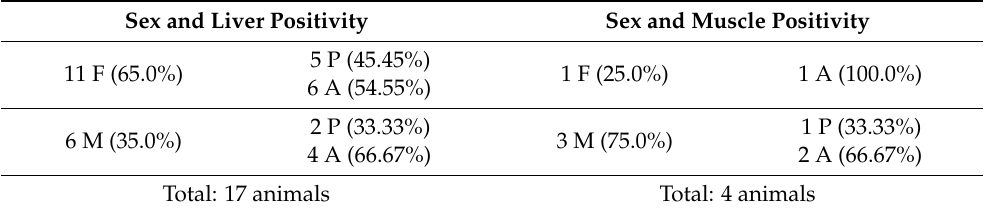
Table 4. Positive animals to the HEV RNA detection classified basing on sex and tissue. Sex and Liver Positivity Sex and Muscle